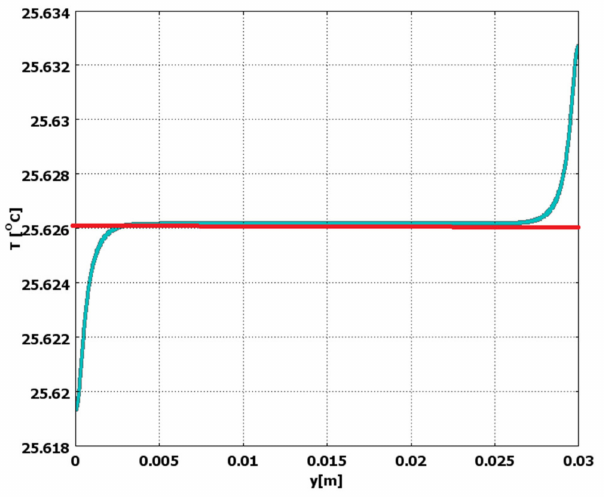
Figure 5. Temperature at the solid interface, for a toluene–methanol binary fluid at x = 0. The analytical solution is shown in red and the numerical calculations are given in